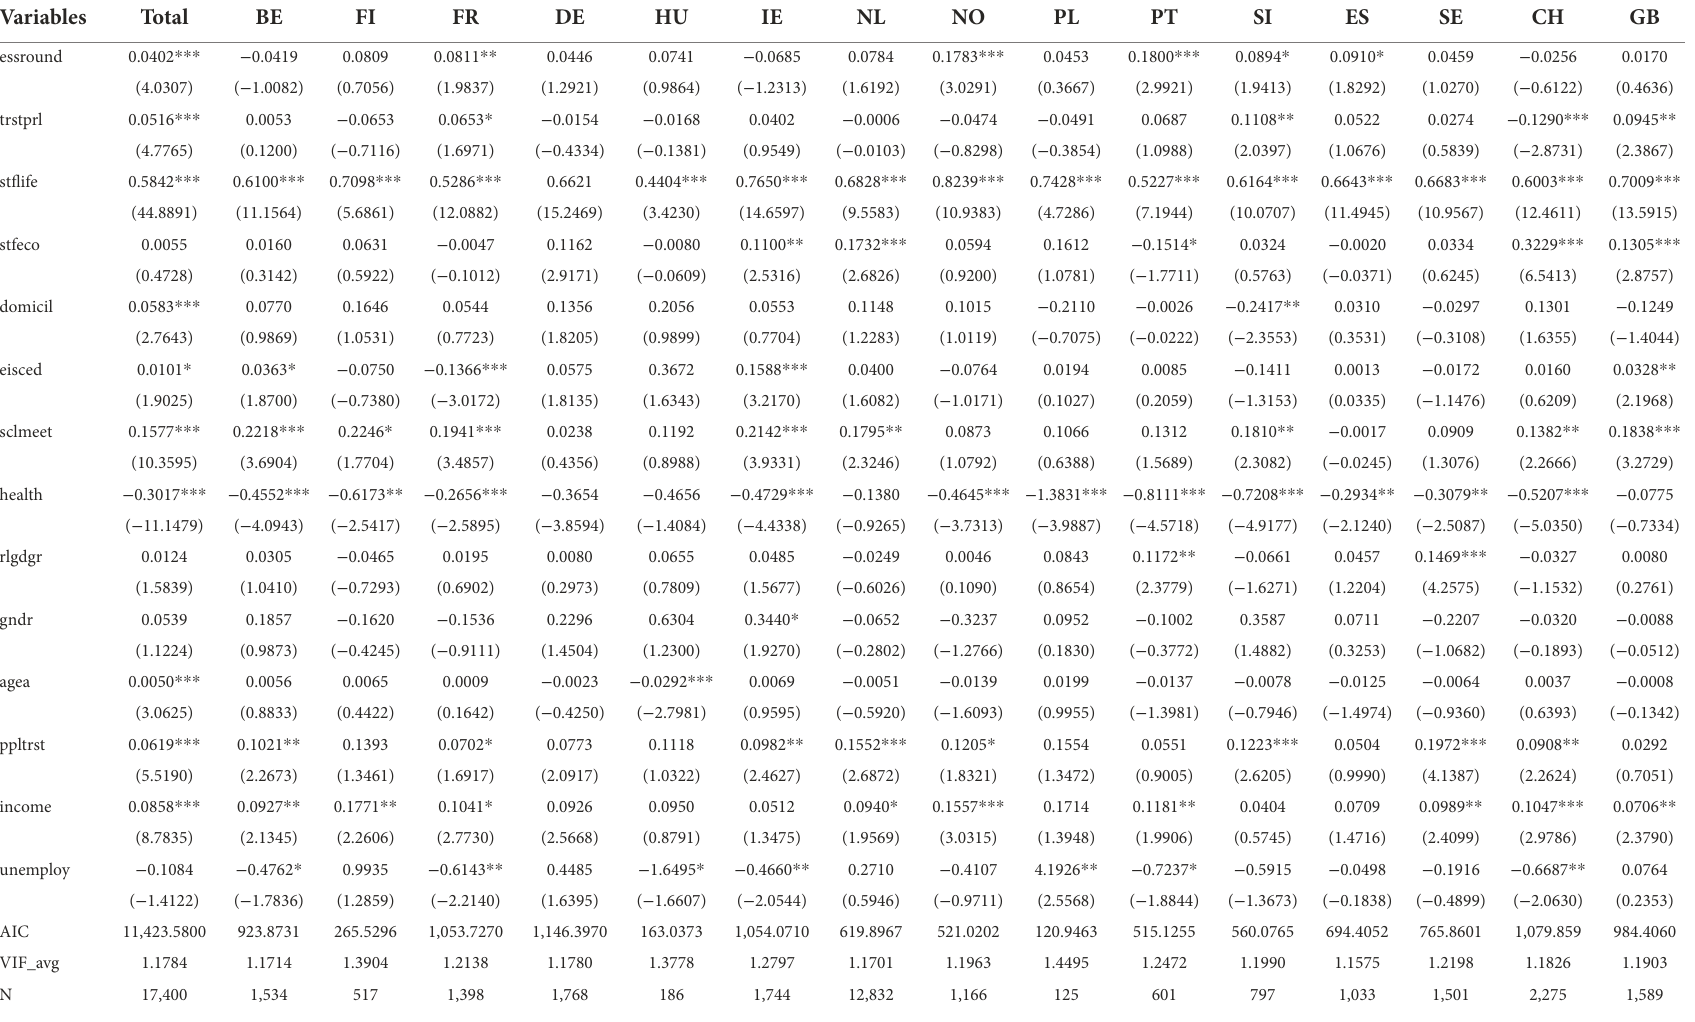
TABLE 3 The comparison of happiness determinants across nations in immigrant group.